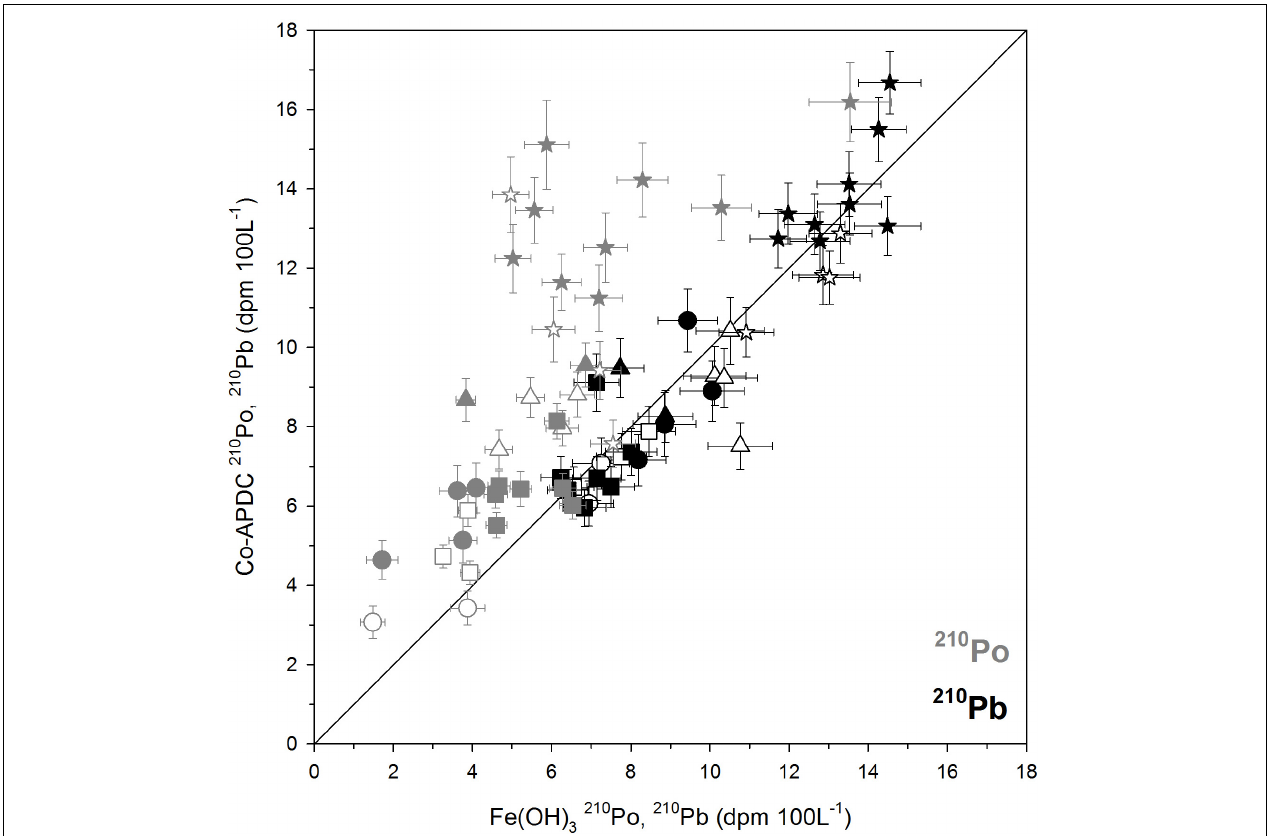
FIGURE 5 | Comparison of 210 Po (gray) and 210 Pb (black) determined by using the Co-APDC ( y -axis) versus the Fe(OH) 3 ( x -axis) methods. Symbols denote different study areas: IONIAN (triangles), CBN (squares), CBS (circles), and SOTS (stars). Open symbols show samples from the primary production zone, while closed symbols correspond to deeper samples. Solid line indicates 1:1